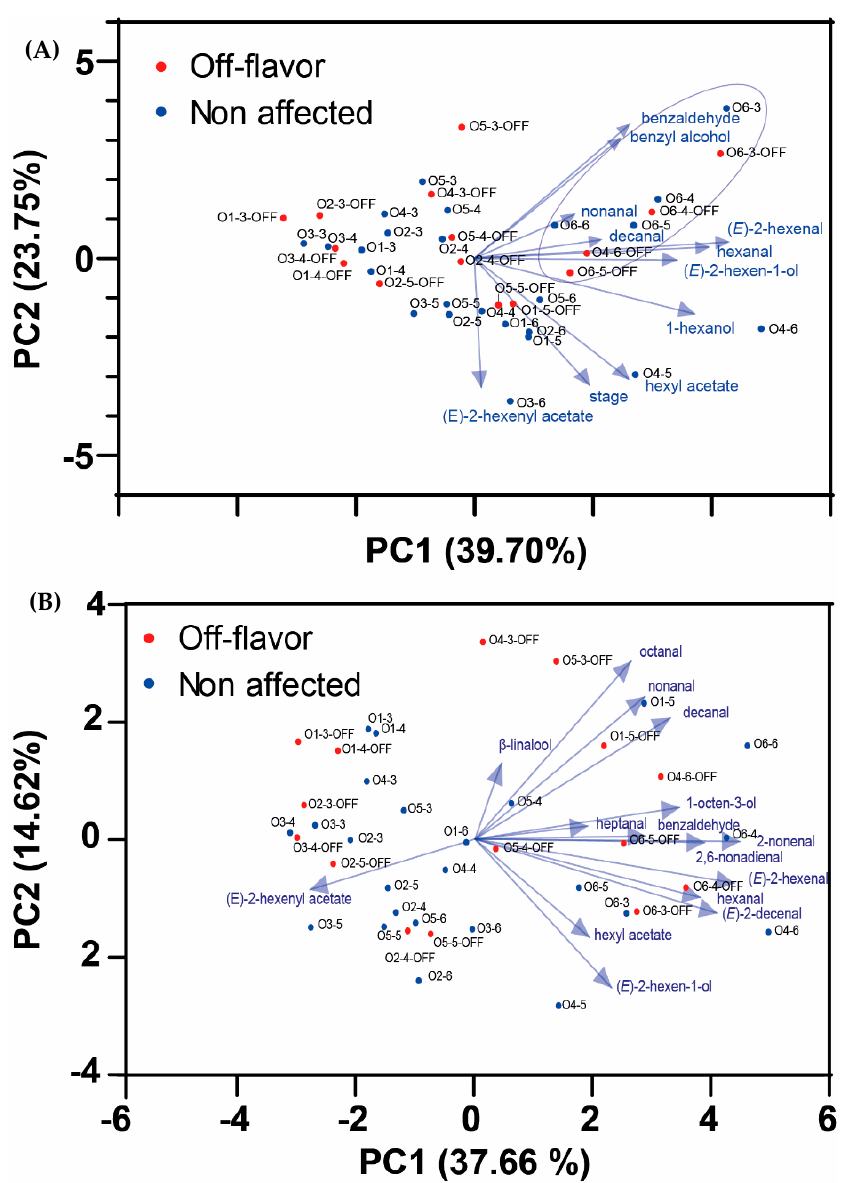
Figure 6. PCA of sweet cherry cv. Regina harvested from six orchards at four phenological stages: ( A ) volatiles with the highest concentration, and ( B ) volatiles with OAVs greater than 0.5. The points are labeled by orchard number (O1 to O6) followed by a hyphen and the phenological stage number (3 to 6), also, the tag ‘OFF’ was added for samples affected with off-flavor.